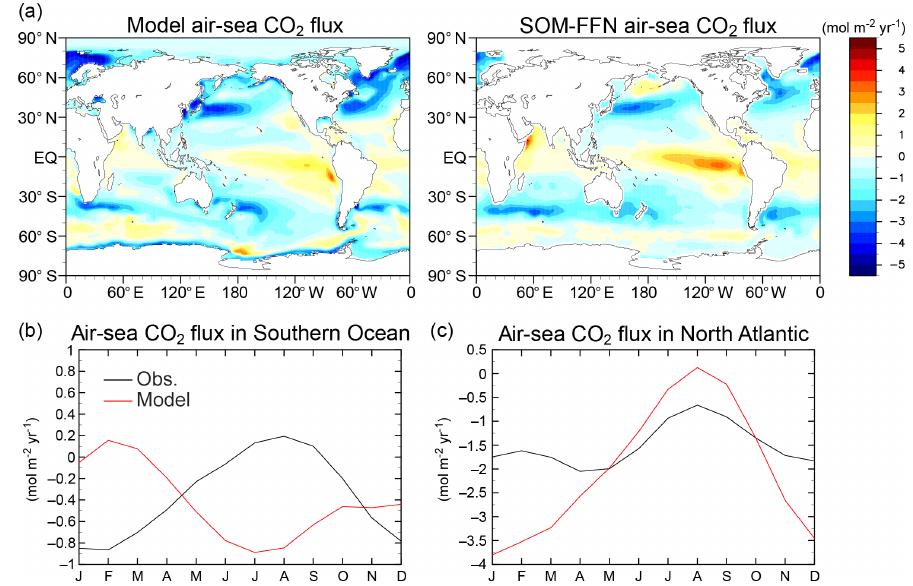
Figure 12. (a) Annual mean air–sea CO 2 fluxes from (left) the model and (right) observational estimates adopted from Landschützer et al. (2014). Seasonal cycle of air–sea CO 2 fluxes for (b) the Southern Ocean and (c) the North Atlantic Ocean. Red lines represent the model for the period 1985–2014, and black lines represent the observation-based estimates of Landschützer et al. (2014). Southern Ocean: 45–70 ◦ S, North Atlantic Ocean: 30–70 ◦